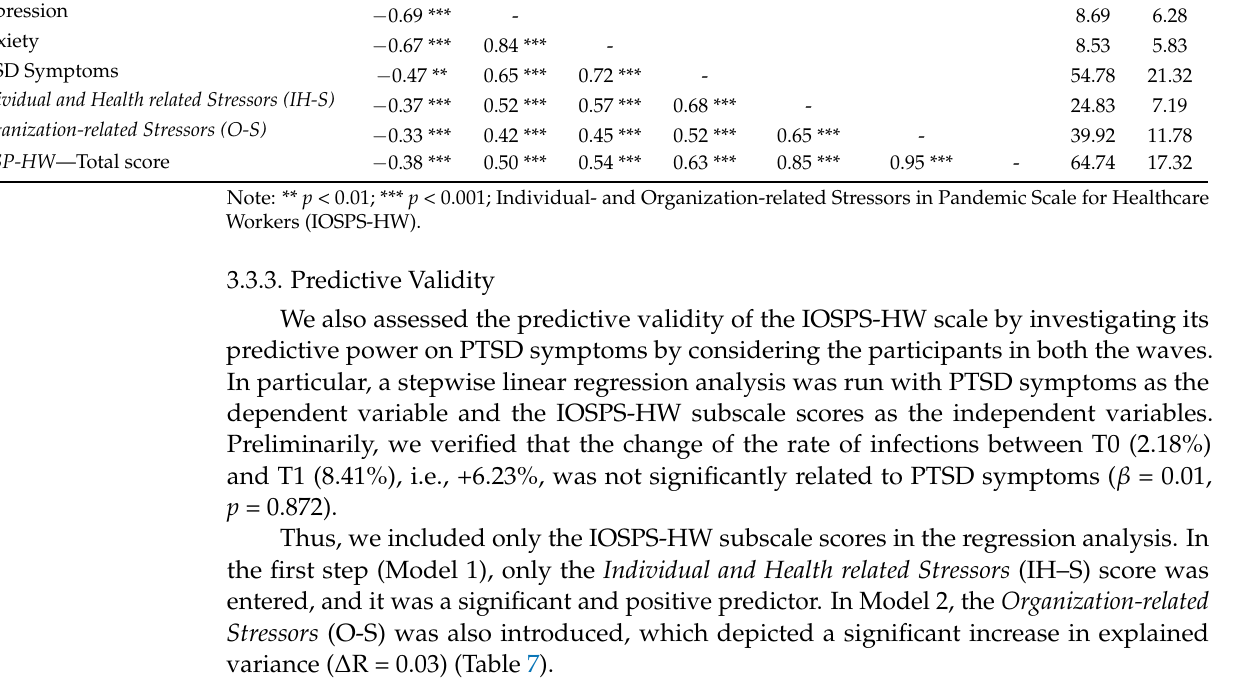
Table 7. Hierarchical linear regression with Individual and Organization related Stressors in Pandemic Scale for Healthcare Workers (IOSPS-HW) subscale score at T0 as independent variables and PTSD symptoms at T1 as dependent